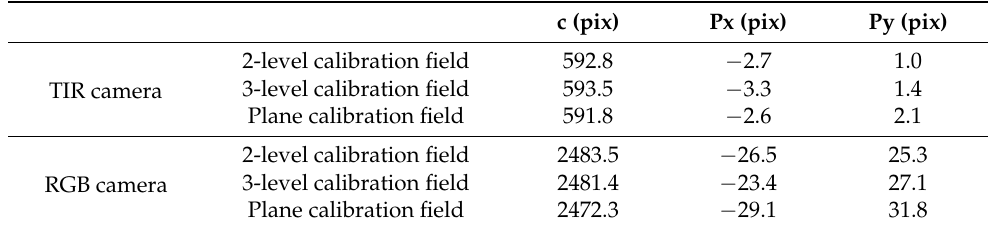
Table 4. The resulting interior orientations of the TIR camera and the RGB camera of FLIR E95, determined on different calibration fields.